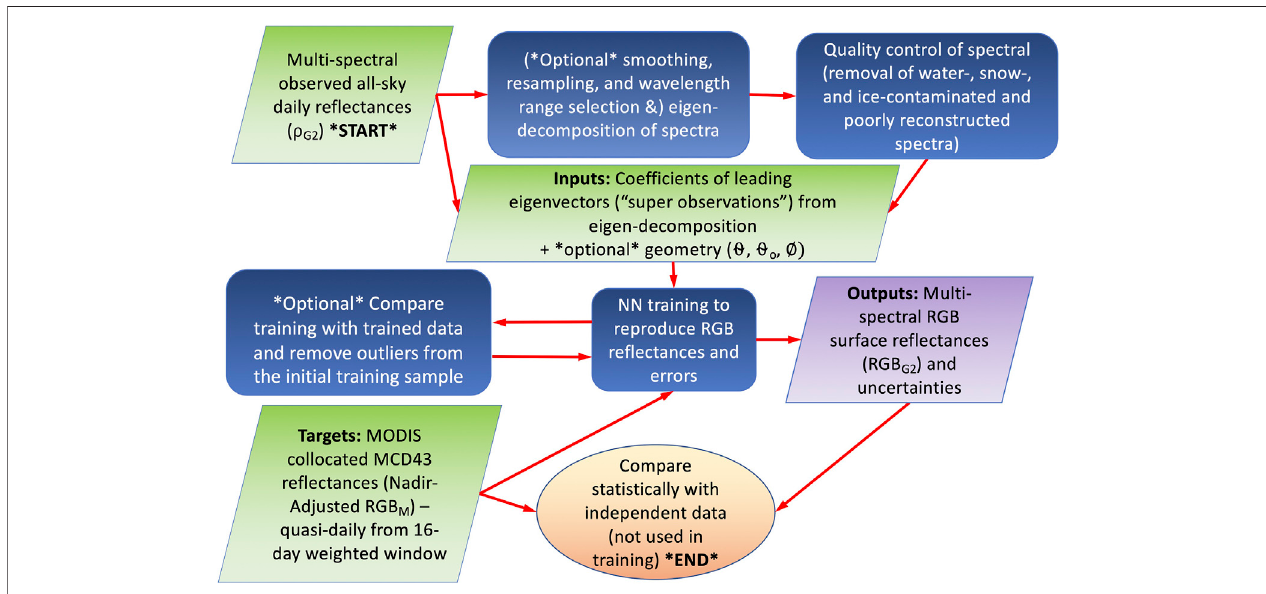
FIGURE 1 | Flow diagram showing how RGB surface re fl ectances and their uncertainties are estimated with machine learning (a neural network, NN) using continuous hyper-spectral measurements from instruments such as GOME-2 trained on MODIS RGB (RGB M ) surface re fl ectances.